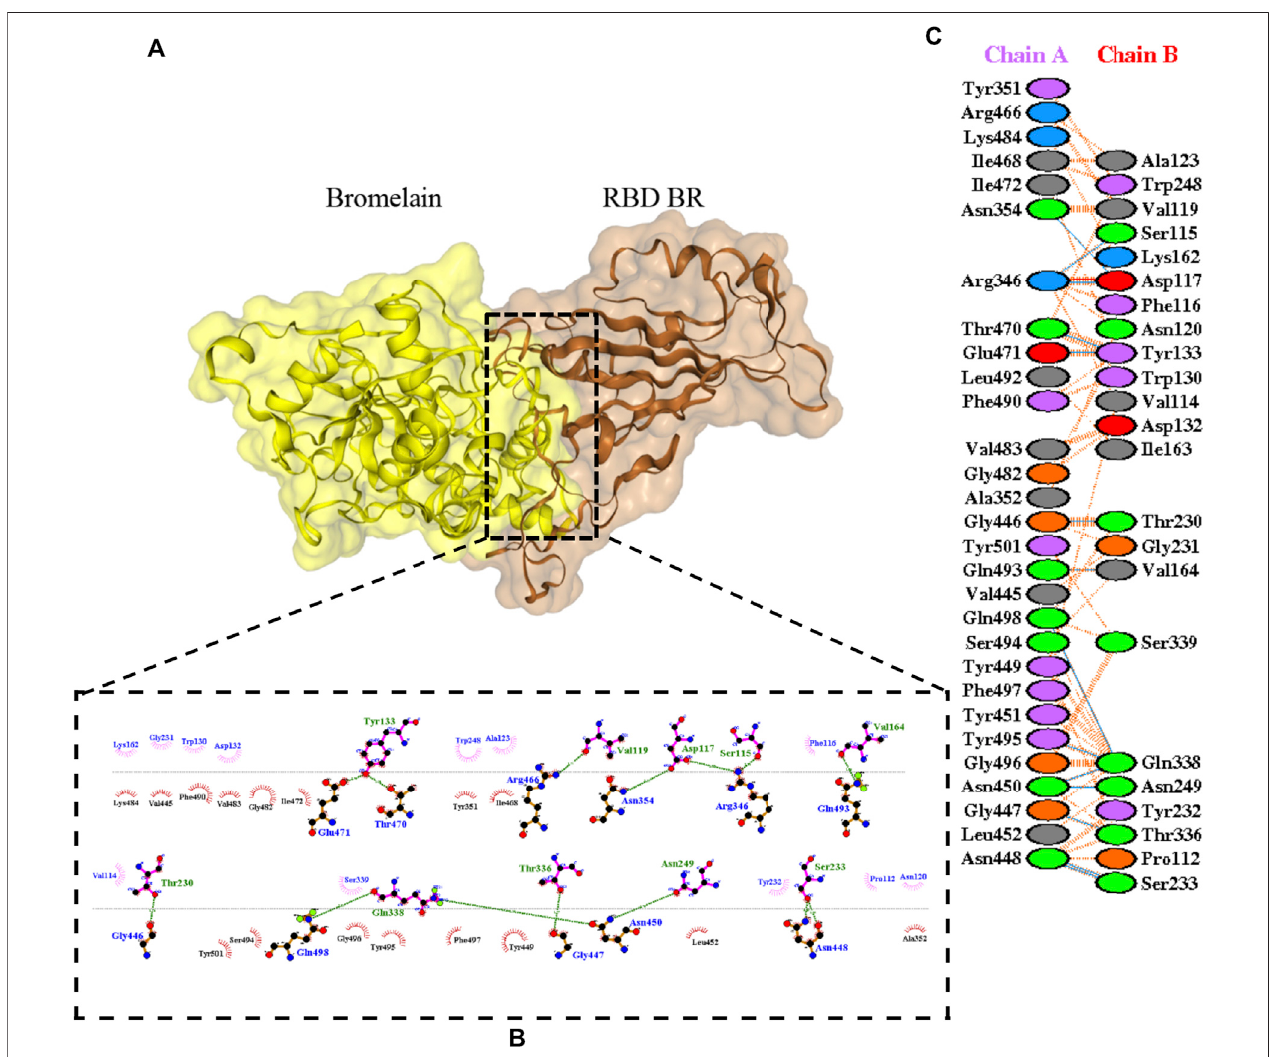
FIGURE 5 | Docking representation of the BR variant and bromelain complex. (A) the binding interface of the complex, (B) the binding interaction between the amino acids, and (C) interaction representation including hydrogen, salt bridges, and nonbonded interactions. Chain A is RBD BR and chain B is bromelain.